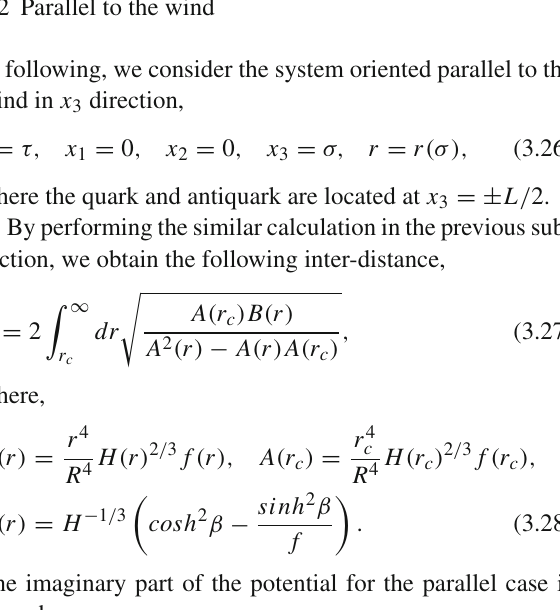
Fig. 2 The large black hole. Left: plot of LT versus ξ for different values of T /(cid:2) and β . Right: ImV T /(cid:2) and